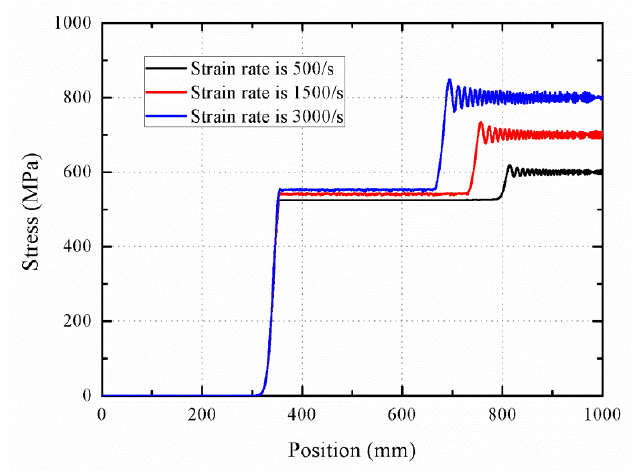
Figure 17. Stress profiles during the wave propagation with various strain rates.